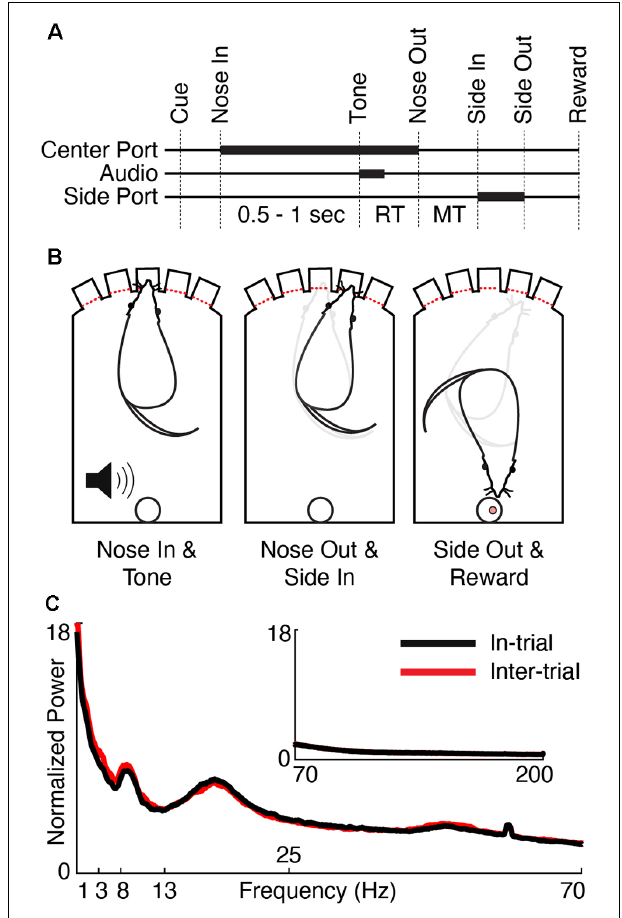
FIGURE 1 | Behavioral task and physiology. (A) Trials began by illuminating one of the three center ports in a five-port behavior chamber (“Cue”). The rat poked and held its nose in the lit port (“Nose In”) for a variable interval (0.5–1 s, pulled from a uniform distribution) until a 1 or 4 kHz auditory cue (“Tone”) instructed the rat to move one port to the left or right, respectively. Nose Out, Side In, and Side-Out indicate when the rat withdrew from the central port, poked the adjacent port, and withdrew from the adjacent port, respectively. “Reward” indicates the time of reward pellet retrieval. Reaction time (RT) and movement time (MT) intervals are labeled. Thick lines indicate either nose port occupancy (Center and Side Port) or playing the auditory cue (Audio). (B) Schematic of the rat operant chamber during key behavioral epochs. (C) Session-averaged normalized power spectra (see “Materials and Methods” section, Power Spectrum ) of low (1–70 Hz) and high (inset, 70–200 Hz) frequencies for in-trial (black) and inter-trial (red)